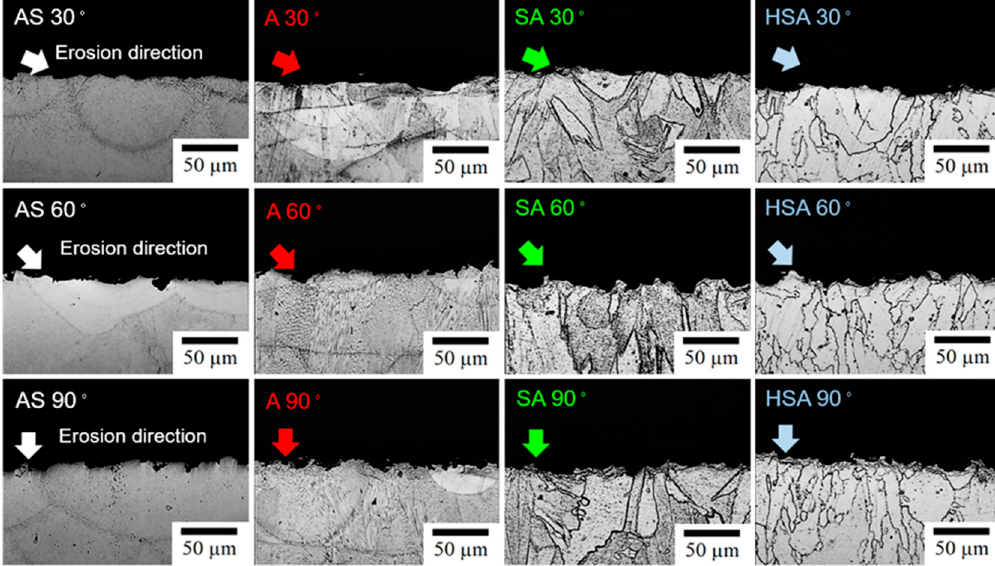
Figure 8. Subsurface morphology of AS, A, SA, and HSA at various impact angles.